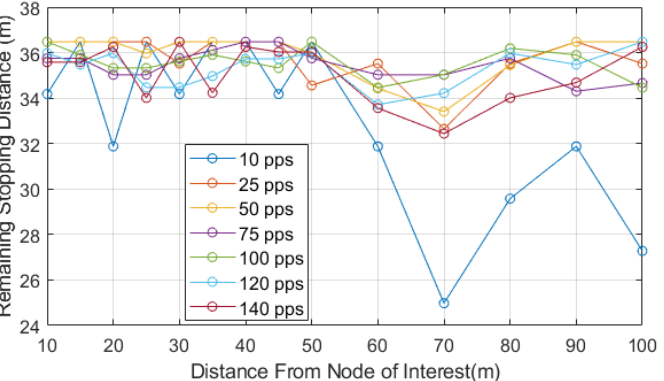
Figure 10. Fifty miles per hour (80.45 km/h) distance dependent reduction in stopping distance.